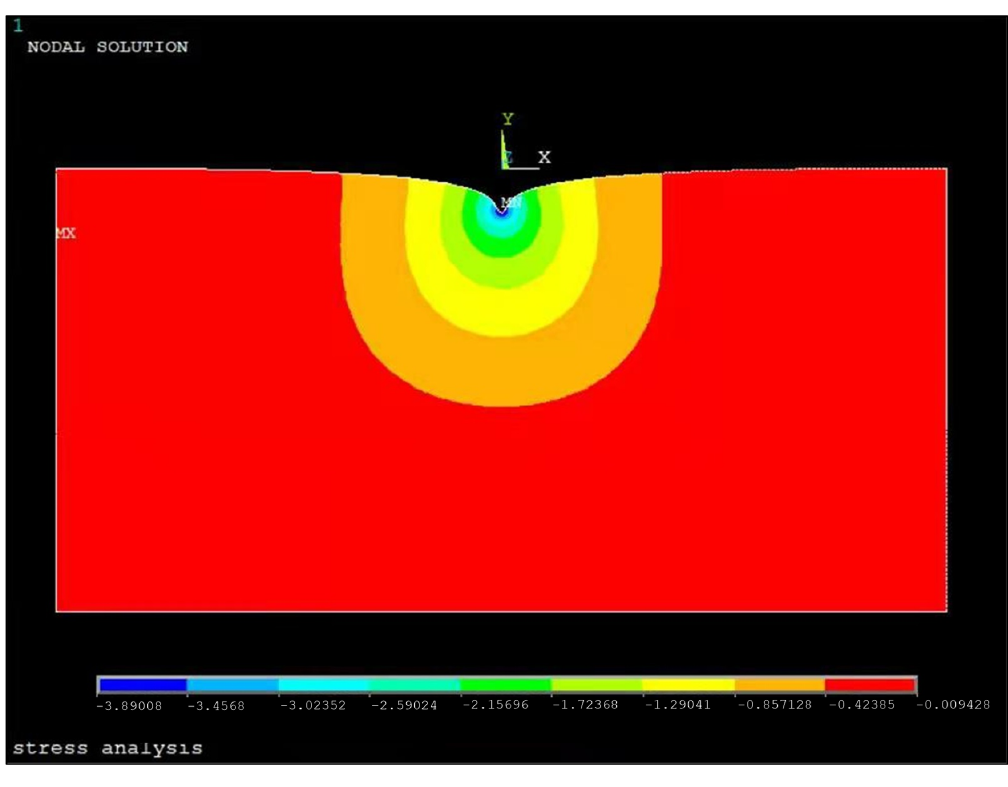
Figure 8. The deformation diagram of ANSYS.